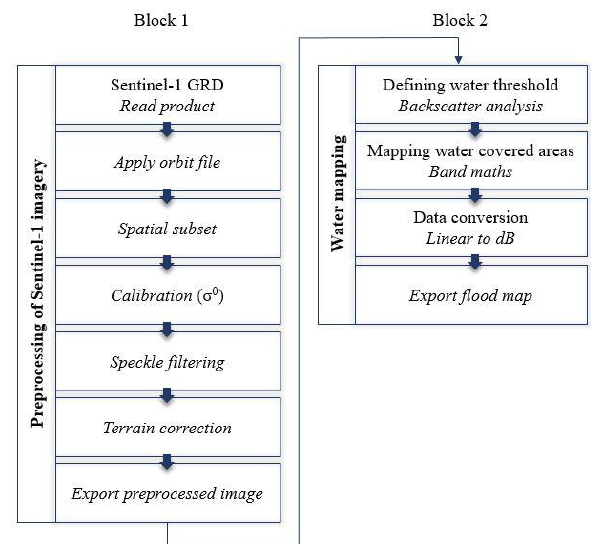
Figure 2. Sentinel-1 and Sentinel-2 post-processing